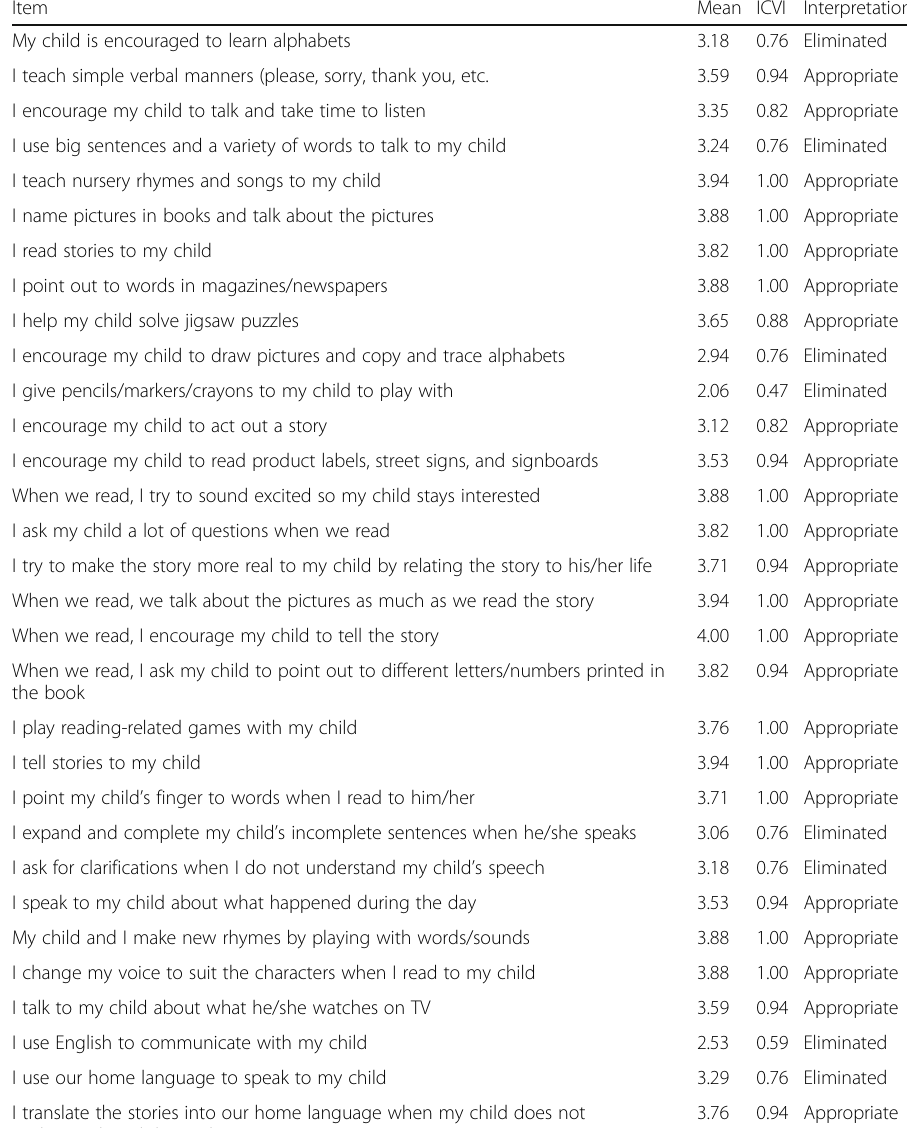
Table 4 Item Level Content Validity Index (ICVI) for the dimension “ Parent-child interaction for language and literacy activities ” (PCI) Item Mean ICVI